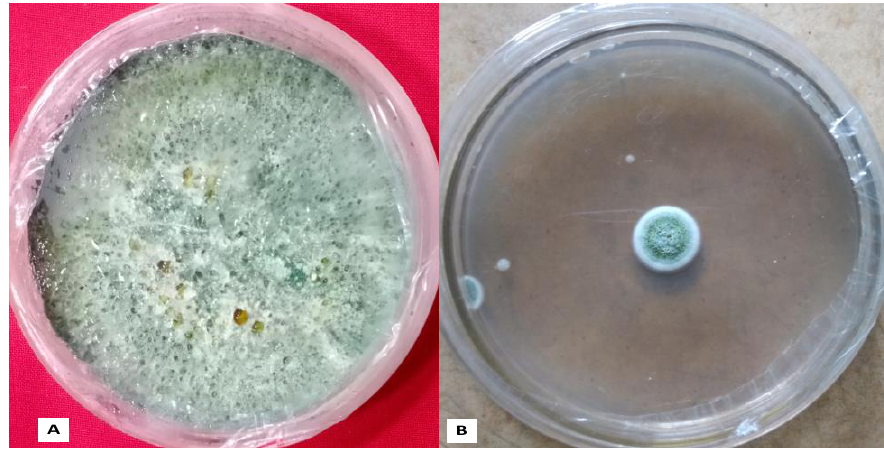
Figure 6. ( A ). Untreated culture of A. flavus; ( B ). A. flavus culture treated with AgNPs.